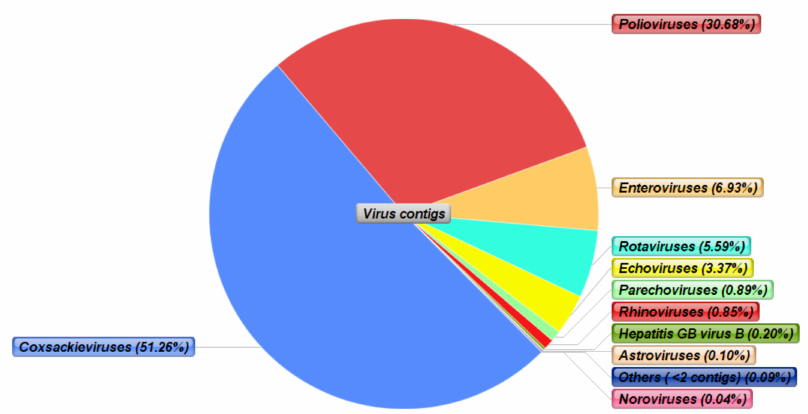
Figure 4. Sequence (contigs) distribution of the detected mammalian RNA viruses at the genus / species level from twelve faecal samples. Coxsackieviruses and polioviruses were the two most abundant species, contributing to 51.26% and 30.68% of the virus contigs,